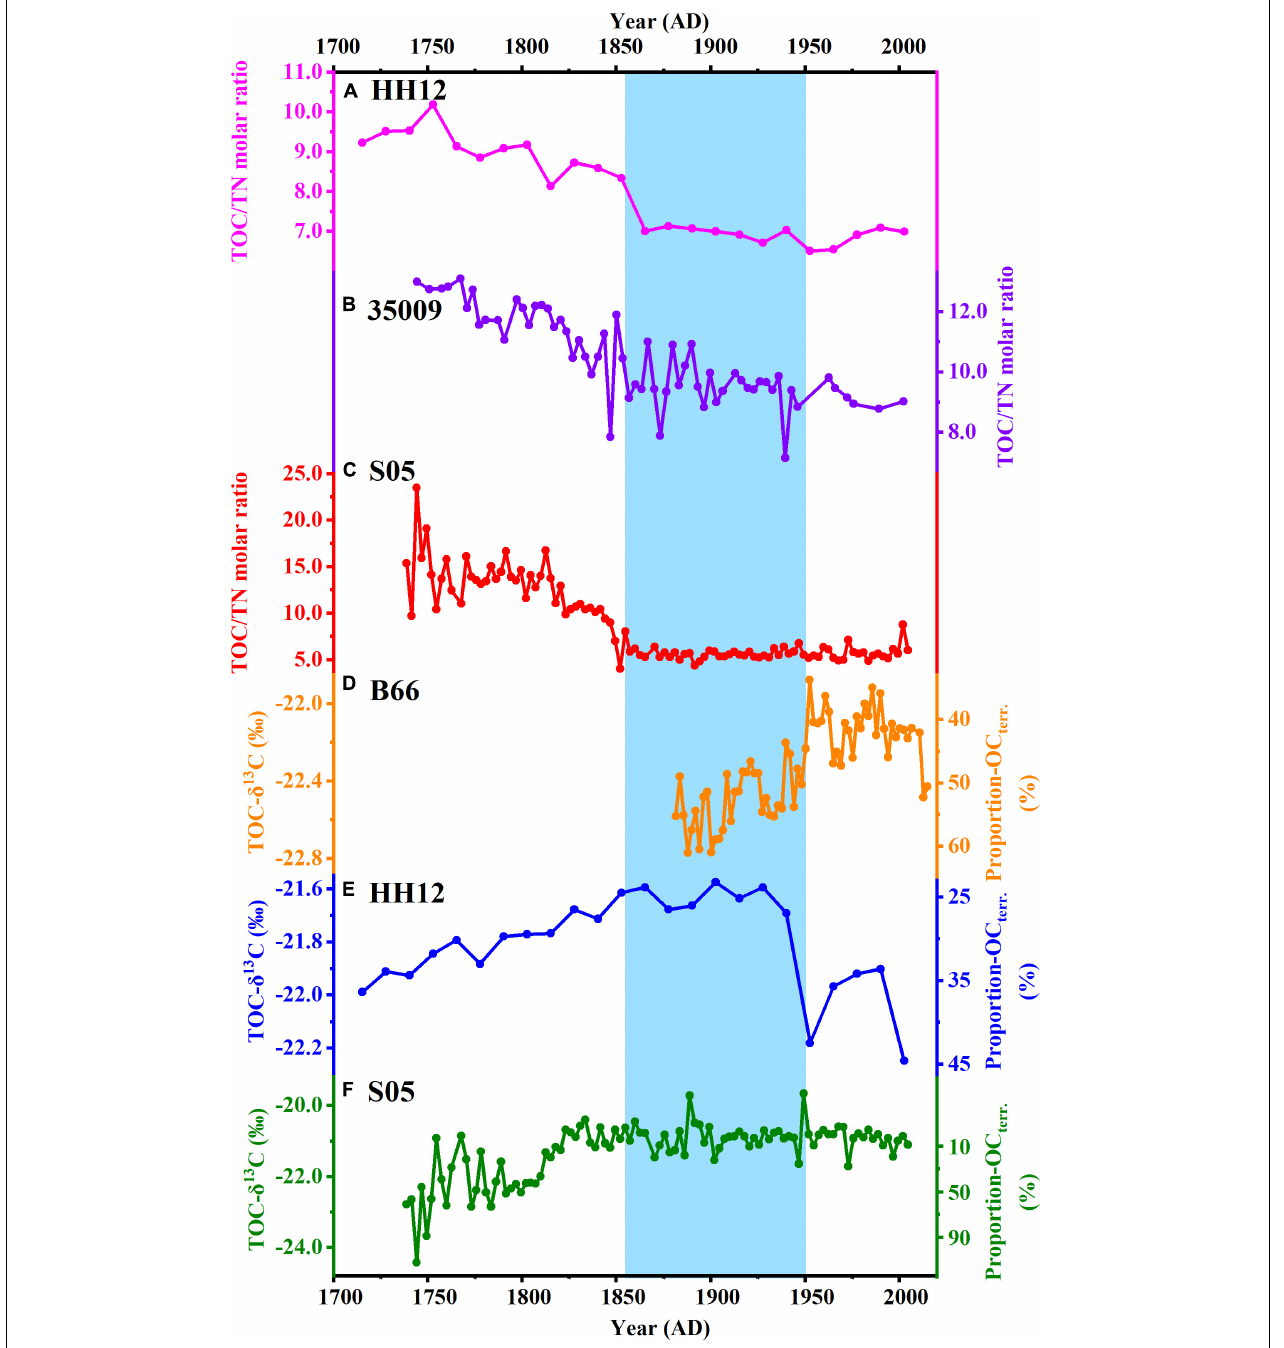
FIGURE 6 | The TOC/TN molar ratio and δ 13 C TOC from cores HH12, 35009, B66 and S05. (A) The TOC/TN molar ratio of core HH12 (this study). (B) The TOC/TN molar ratio of core 35009 (Zhou X. et al., 2014). (C) The TOC/TN molar ratio of core S05 (Yang et al., 2009). (D) The δ 13 C of TOC of core B66 (Xiao et al., 2020). (E) The δ 13 C of TOC of core HH12 (this study). (F) The δ 13 C of TOC of core S05 (Yang et al., 2009). Proportions of terrestrial OC calculated using δ 13 C binary mixing model were also labeled in (D–F) displayed on the right Y-axis of each panel.